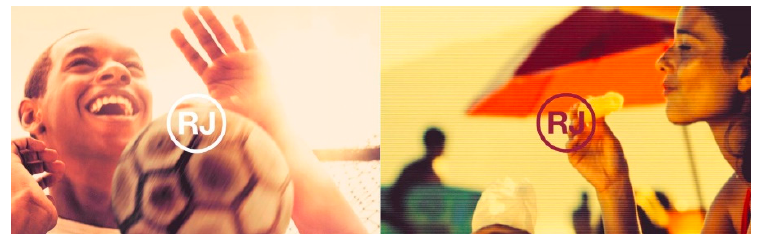
Figure 2. RJ brand launched in 2011.